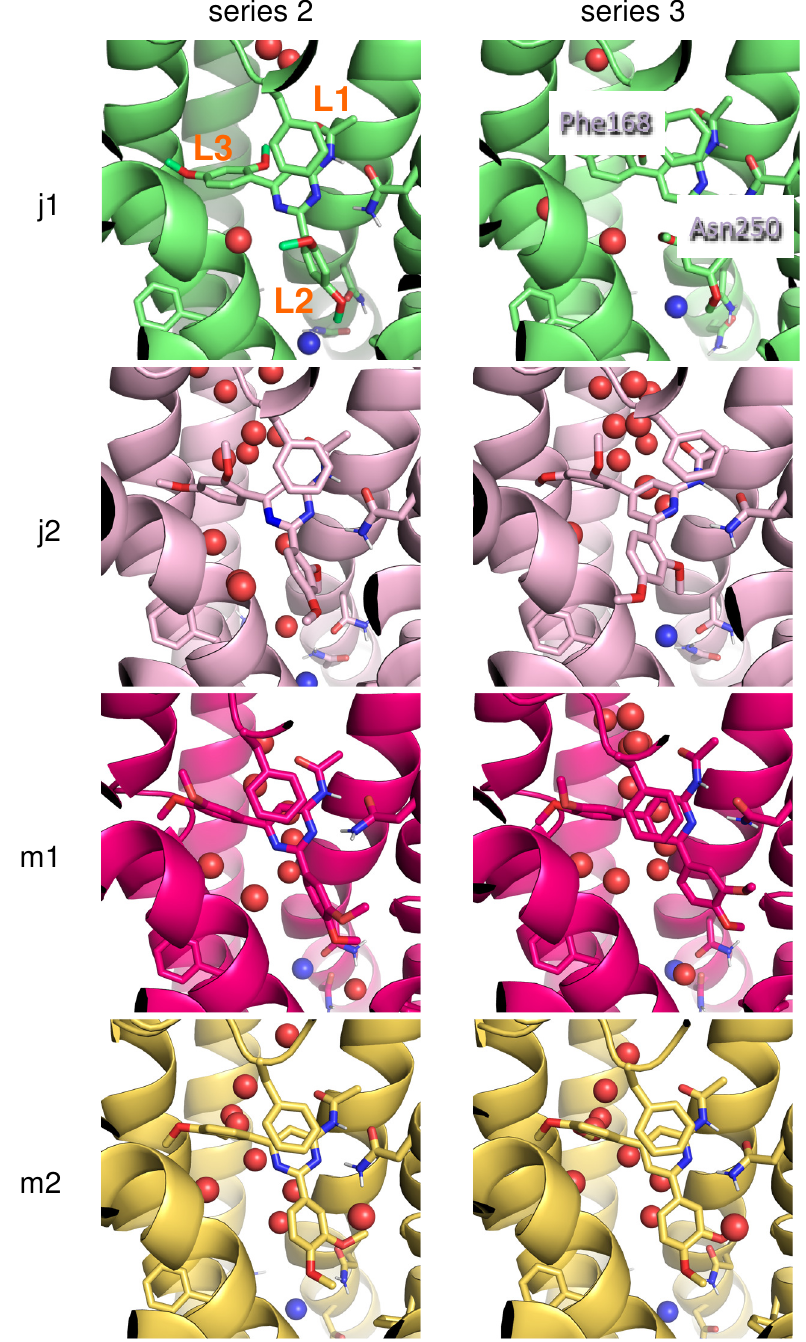
Figure 1. Initial and final poses of ligands in the 2 > 3 transformation for compounds j and m, in two distinct starting poses. For 2j1 the three ligands sites (L1, L2, L3) are indicated, for 2j2 the most important residues are labeled. Red spheres correspond to water molecules, the blue sphere to the Na + ion.